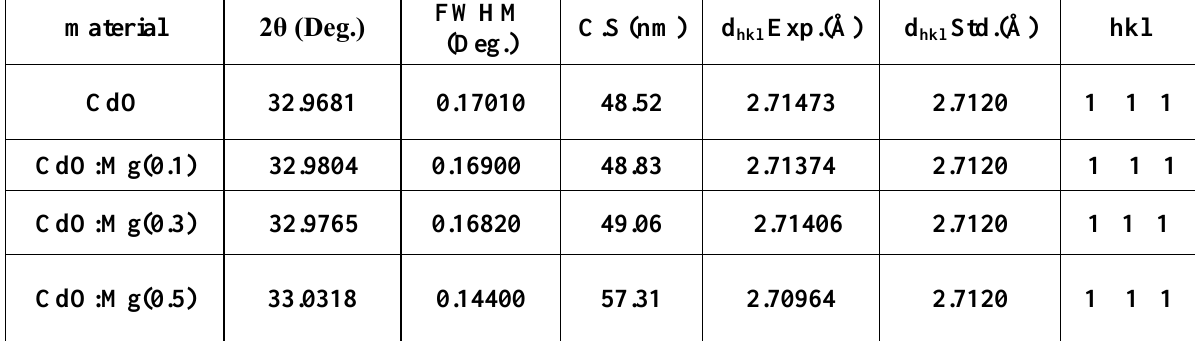
Table 1: Structural parameters of (CdO: Mg) films obtained from (XRD)